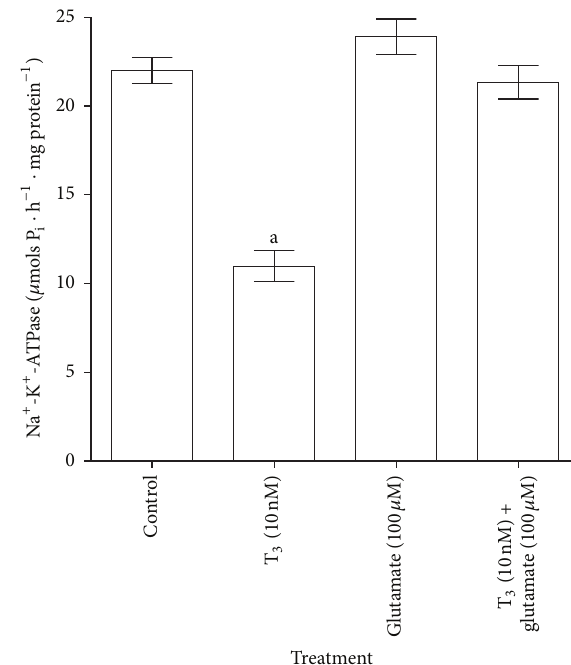
Figure 5: Modulation of the T 3 action on synaptosomal Na + -K + - ATPase activity by an 𝛼 2 -adrenergic agonist (CLO) and an 𝛼 2 - adrenergic antagonist (YOH) in vitro . The data are represented as mean ± SEM of six separate experiments taking six animals in each group. a 𝑃 < 0.001 ,comparedtothecontrolgroup(one-wayANOVA followed by Newman-Keuls test). The vertical lines denote SEM.